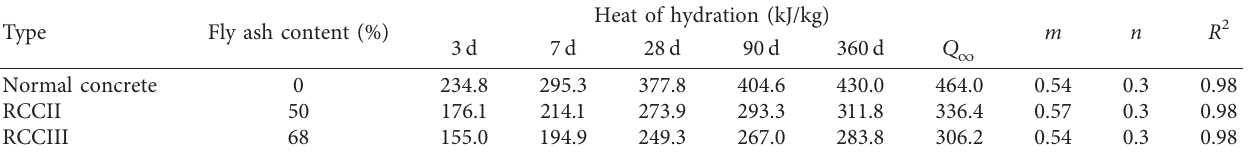
Table 5: Hydration heat of concrete.